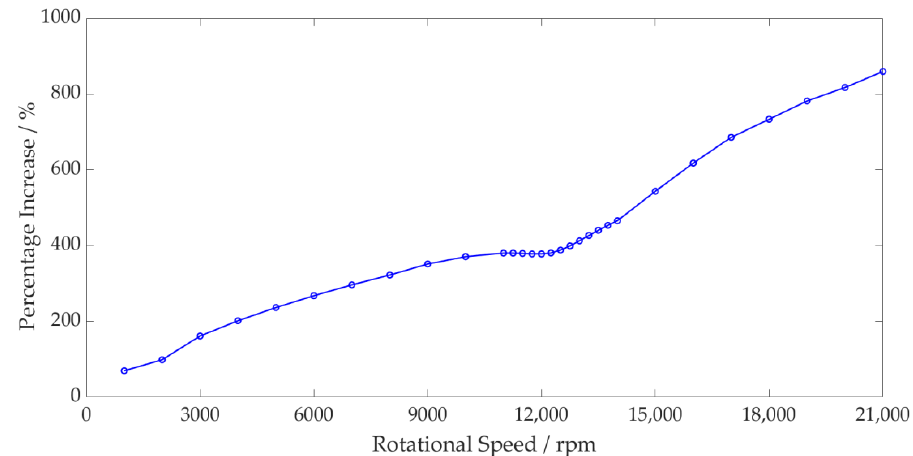
Figure 8. Rolling Element Contact Force — Dry vs. Lubricated Percentage Increase.